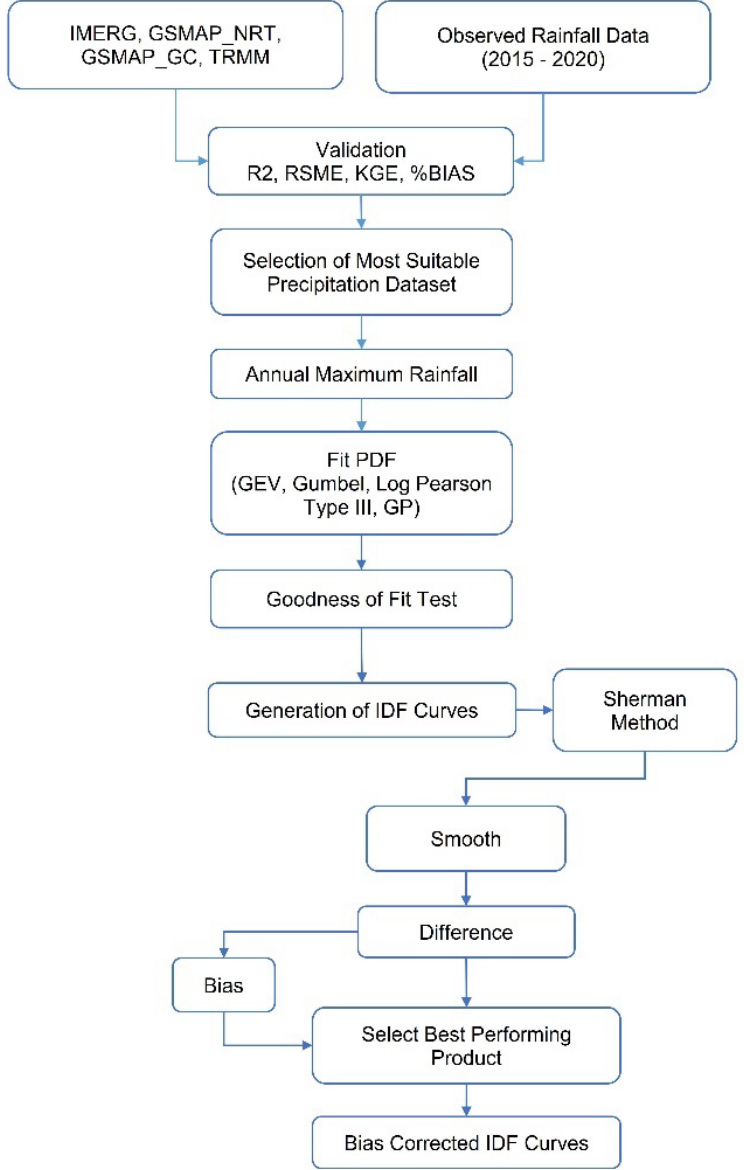
Figure 2. The flowchart of the procedure employed in the present study.